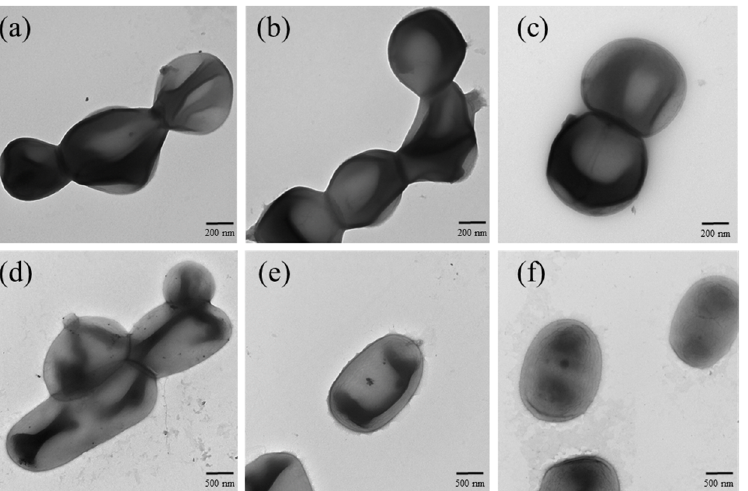
Figure 11. TEM images of S. aureus treated with ( a ) A-BG-AgNPs, ( b ) E-BG-AgNPs and ( c ) untreated bacteria cells, respectively. TEM images of A. baumannii treated with ( d ) A-BG-AgNPs, ( e ) E-BG- AgNPs, and ( f ) untreated A. baumannii cells, respectively.